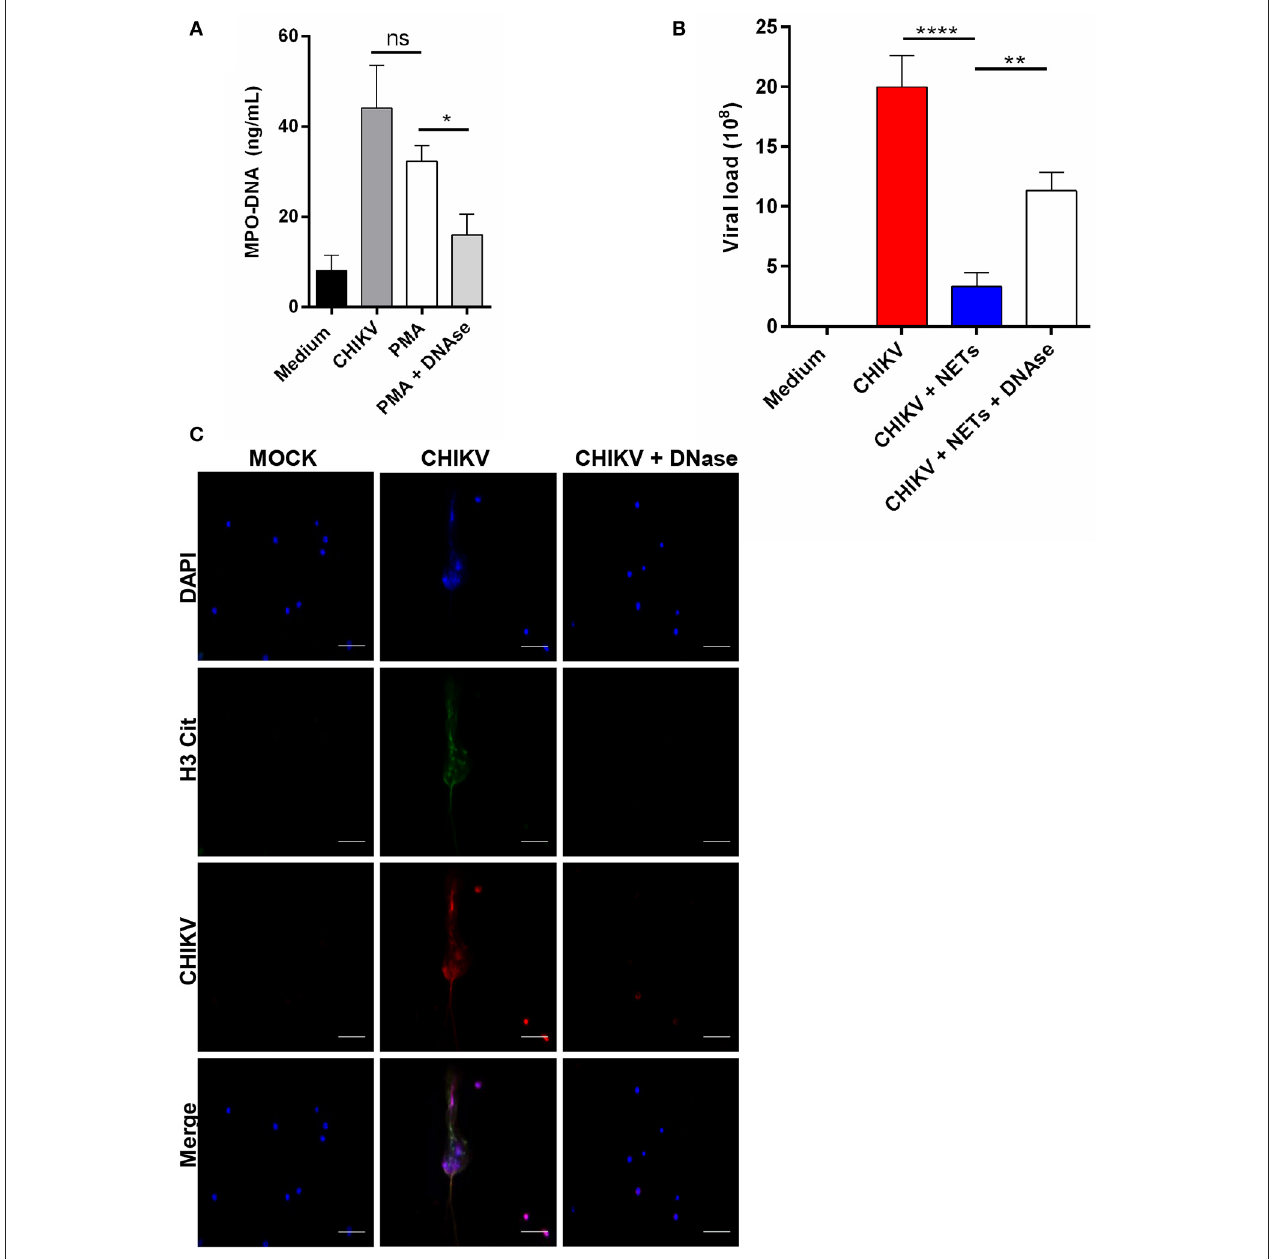
FIGURE 3 | NETs release contributes to virus neutralization. (A) Quantification of NETs by MPO–DNA PicoGreen in the supernatant of mouse neutrophils incubated with medium, CHIKV, PMA (100nM), and DNase (5 mg/ml) for 4h. (B) Viral load quantification by PFU assay of CHIKV virus stocks incubated with medium, NETs, or NET predigested with DNase for 2h. (C) Representative immunofluorescence image of mouse neutrophils incubated with CHIKV (MOI = 5 for 4h). Bars = 50 µ m. Magnification × 40. Cells were stained with DAPI ( blue ), anti-H3 citrulline ( green ), and anti-CHIKV ( red ). Data are presented as mean ± SD ( n = 4 per group); * p < 0.05, ** p < 0.01, and **** p < 0.0001, assessed by one-way ANOVA with Bonferroni’s comparisons test. Representative results of two experiments performed independently.